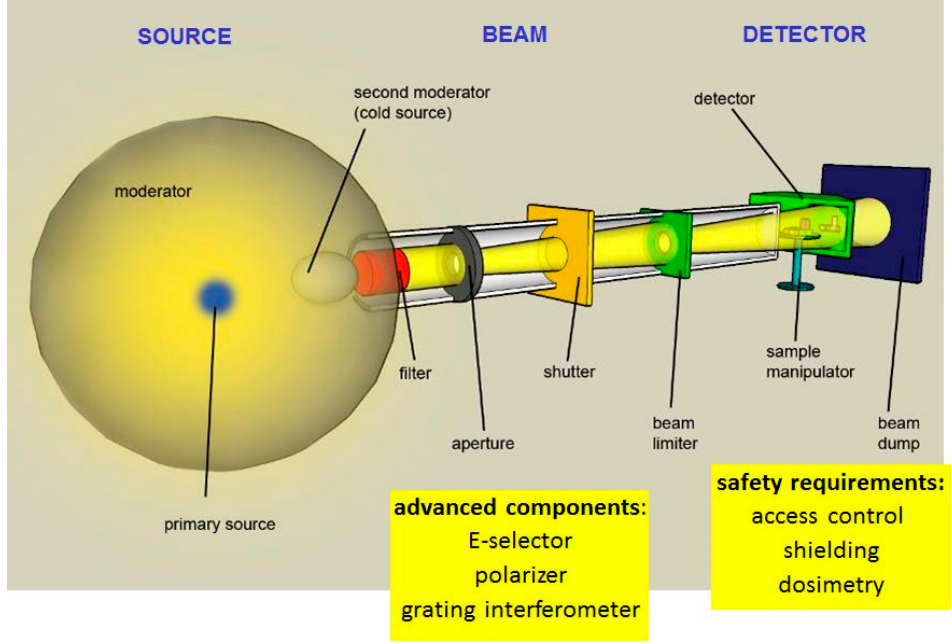
Figure 1. Components of a generic NI facility (not to scale).